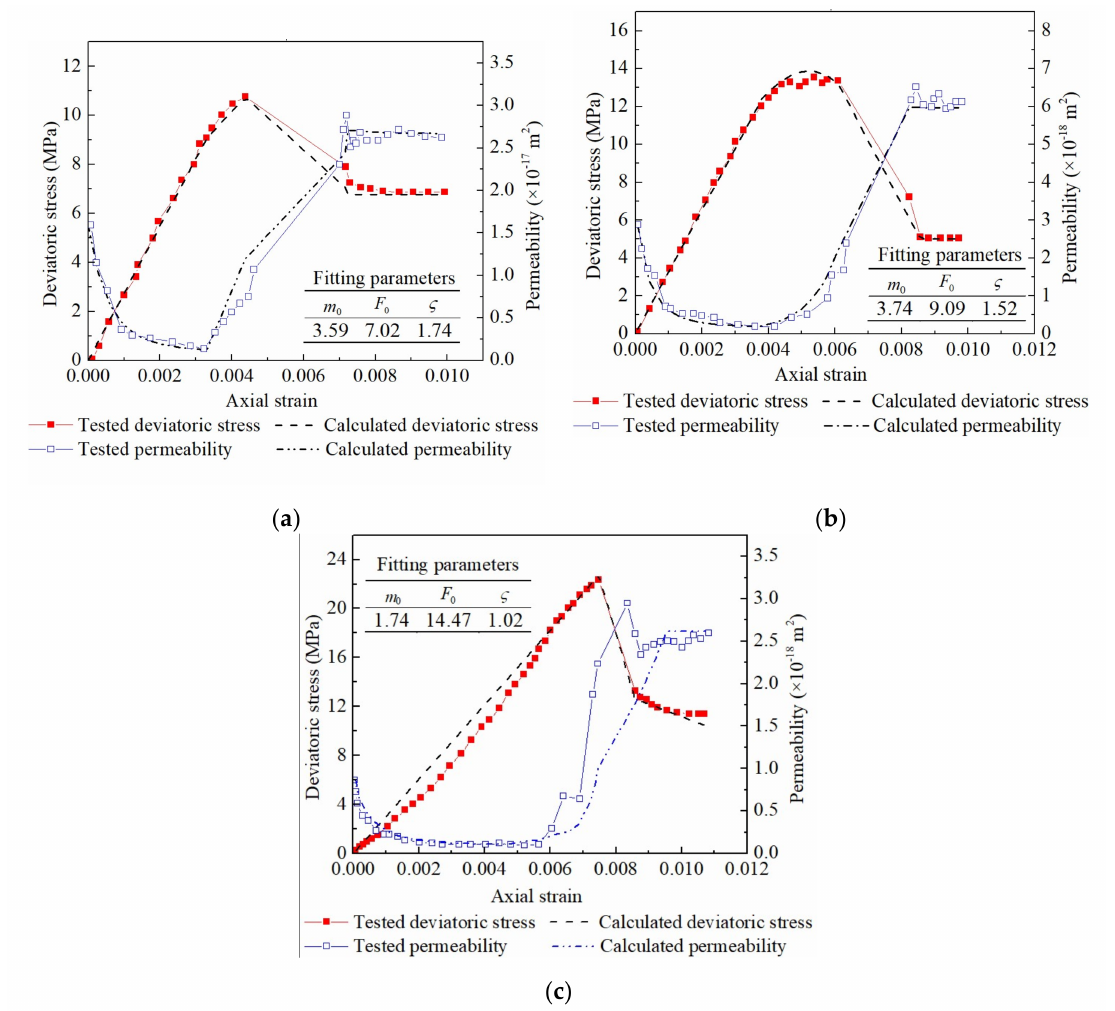
Figure 7. WCR permeability variation curves under different confinement conditions: ( a ) confining pressure 2.0 MPa; ( b ) confining pressure 3.5 MPa; ( c ) confining pressure 5.0